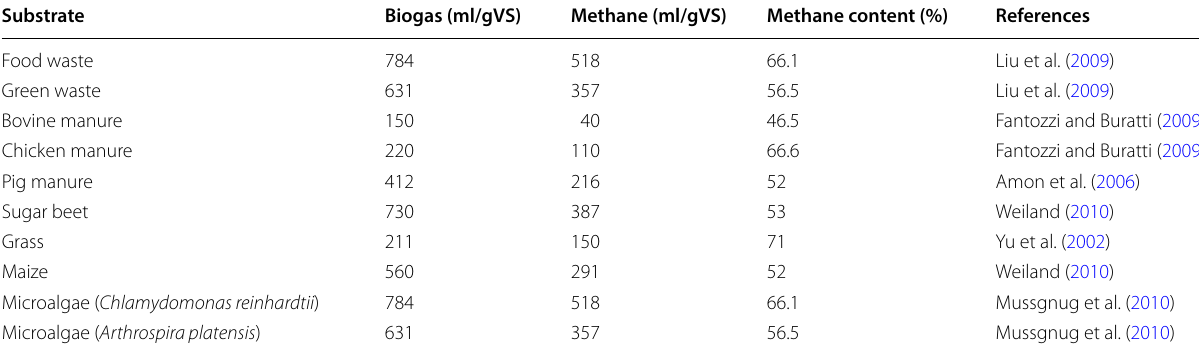
Table 2 Biogas production from organic wastes